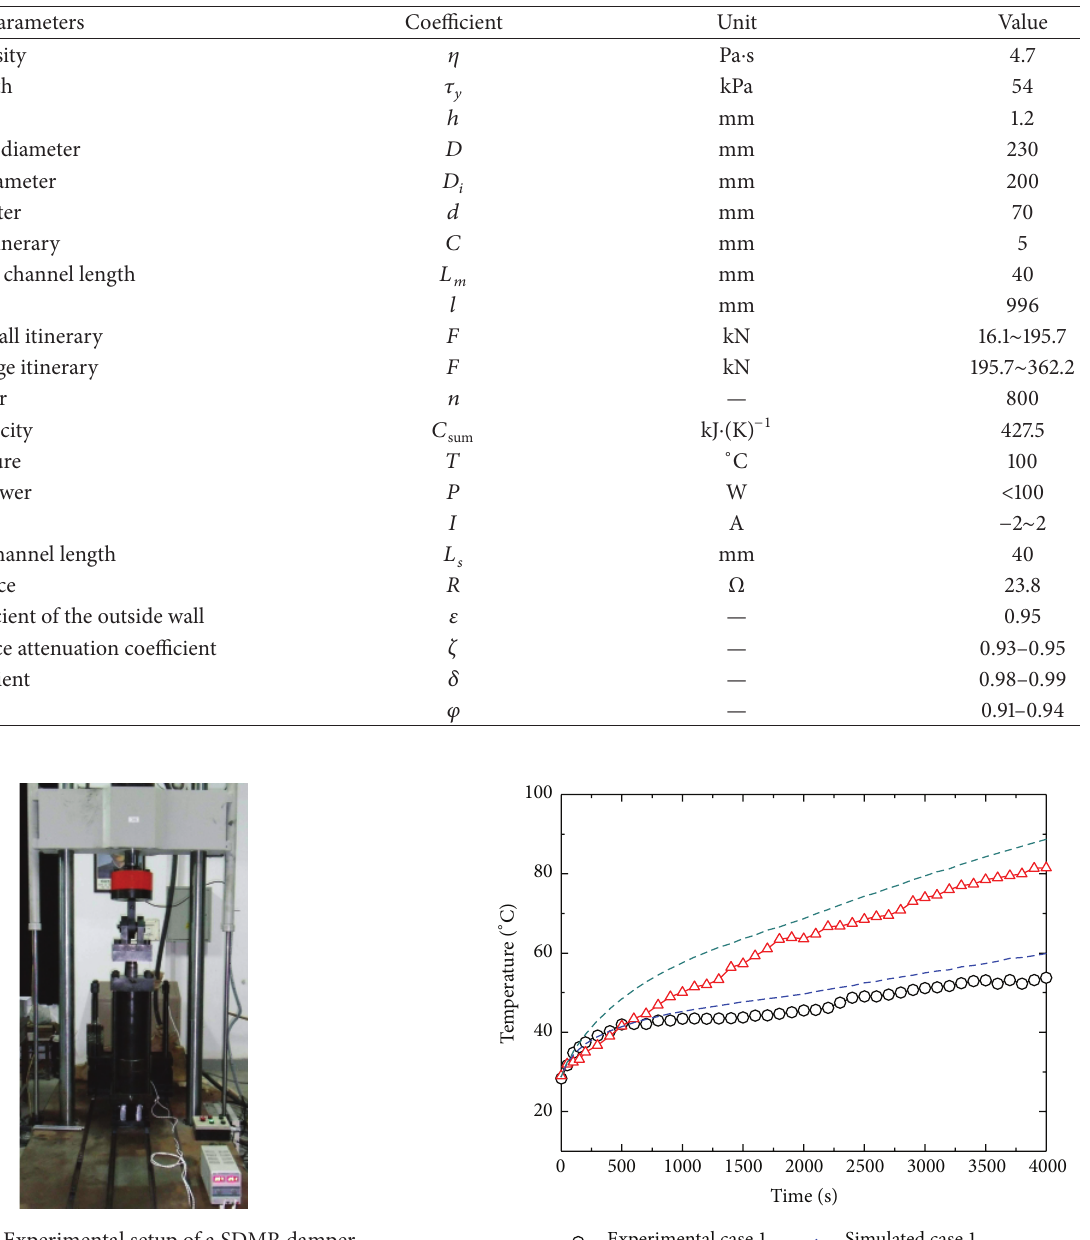
Figure 6: Experimental setup of a SDMR damper. Table 3: MR damper temperature performance test cases.